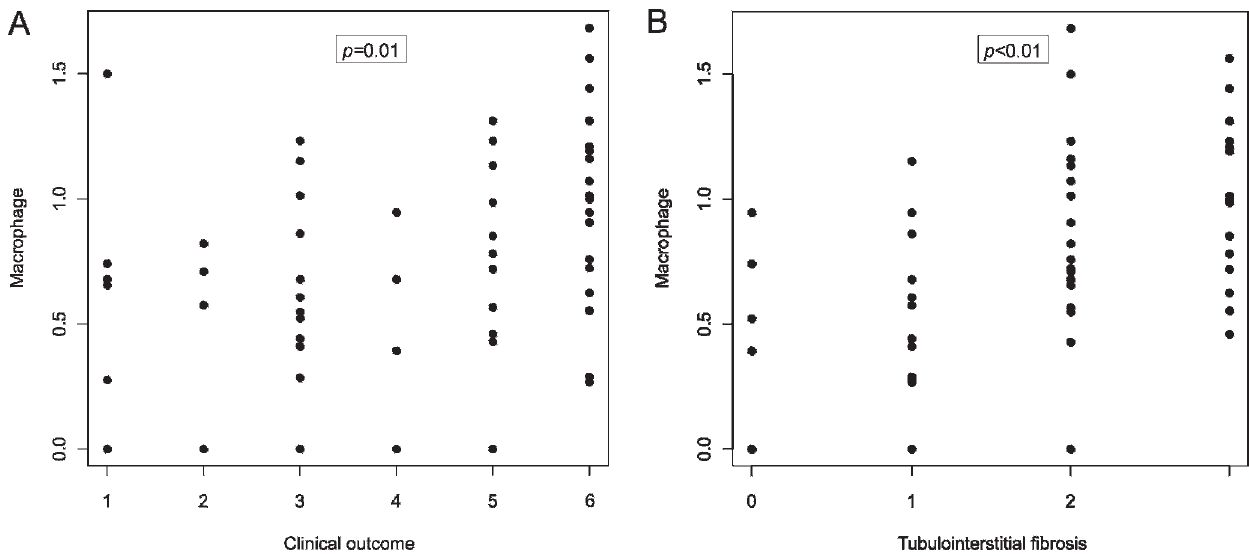
Figure 4 - A dispersion graph showing the relationship between the number of cortical macrophages and the following variables: (A) clinical outcome (1, clinical remission; 2, clinical improvement; 3, unchanged; 4, clinical worsening; 5, chronic kidney disease; 6, end- stage renal disease) ( p =0.01) and (B) tubulointerstitial fibrosis score (0, absent; 1, mild; 2, moderate; 3, severe) ( p ,